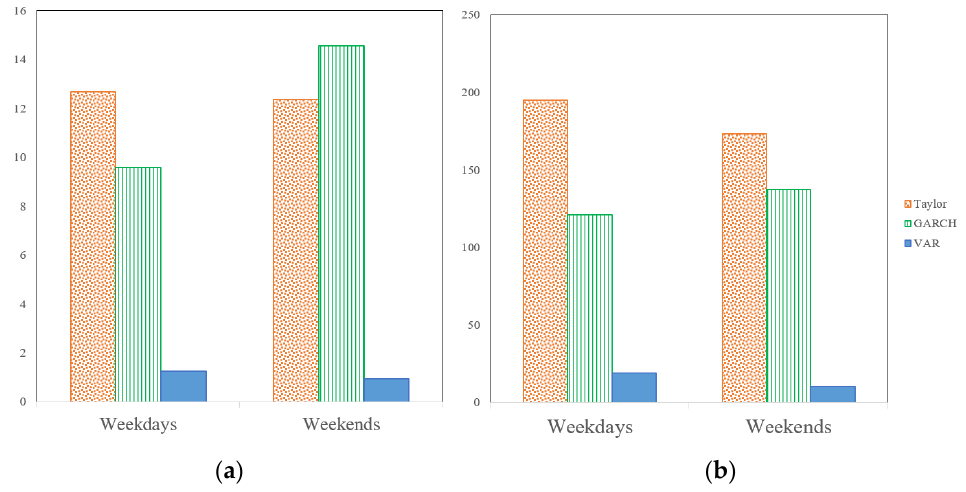
Figure 3. Forecast (k = 1) performance evaluations categorized by day type for models in terms of ( a ) MAPE and ( b ) RMSE.